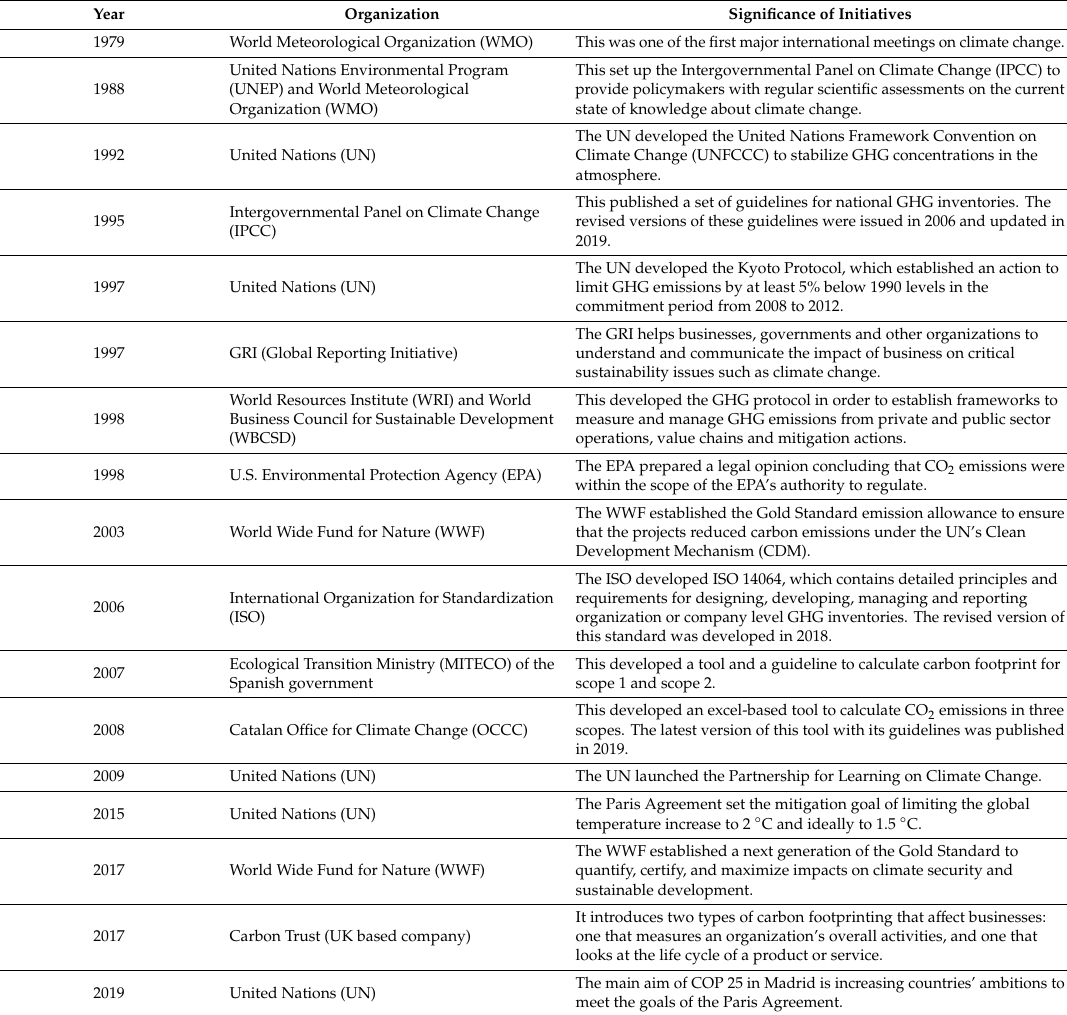
Table 1. Summary of international initiatives to control climate change and carbon footprint in